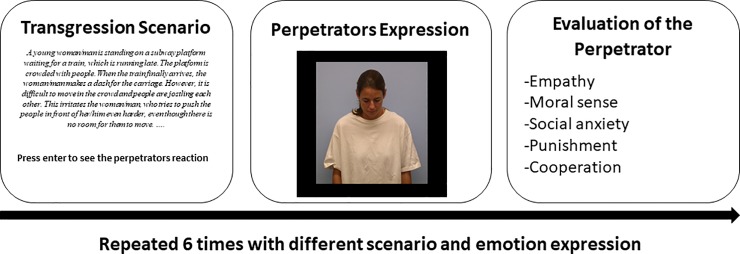
Flowchart of Study 2 trial structure.